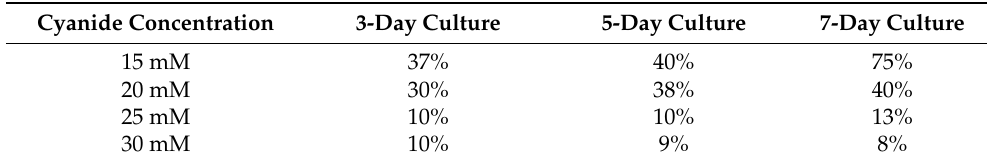
Table 2. Percentage of cyanide degradation by T. harzianum in different cultures with four cyanide concentrations.